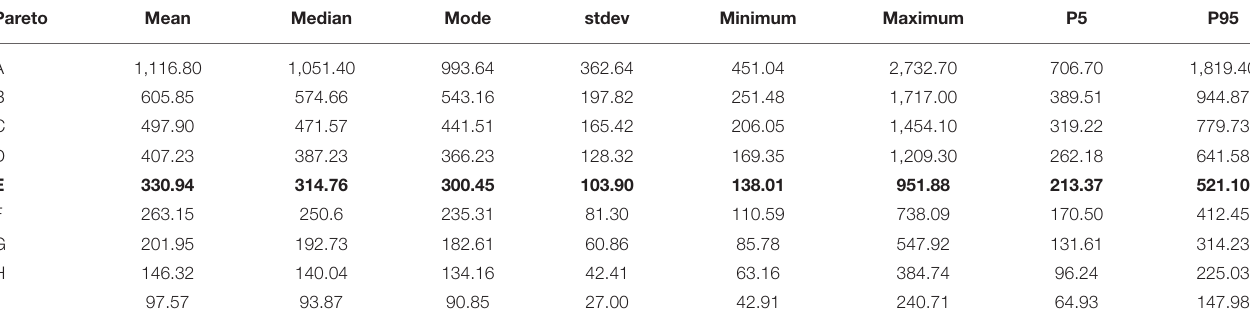
TABLE 4 | Characteristics of BTEX emission at the Pareto optimal points as obtained from stochastic solution (ton/yr).